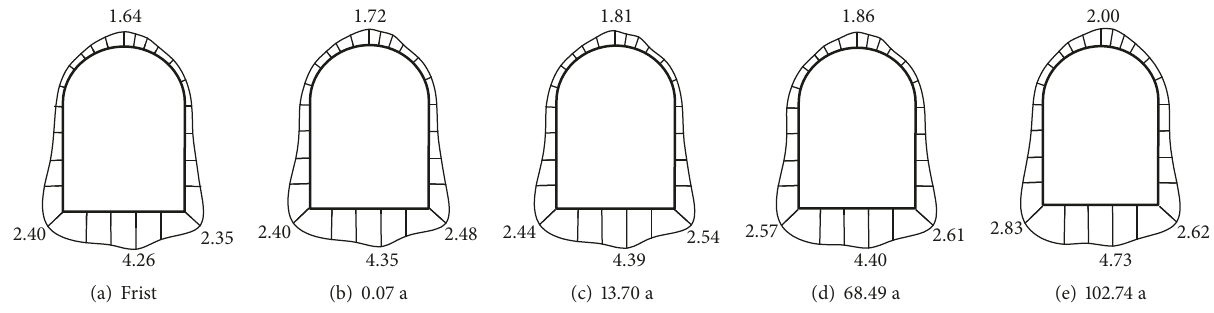
Figure 15: Maximum envelope of acceleration at different operation times (MPa).